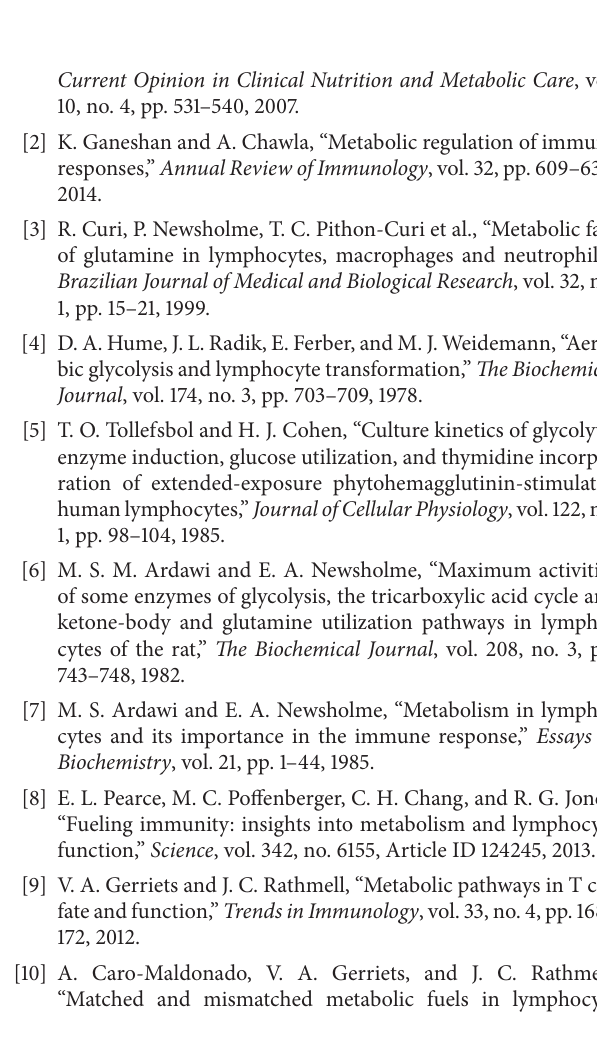
Figure 1: Exercise counterbalances lymphocyte metabolic dysregulation, modulating several components of glycolysis and glutaminolysis. HIV—human immunodeficiency